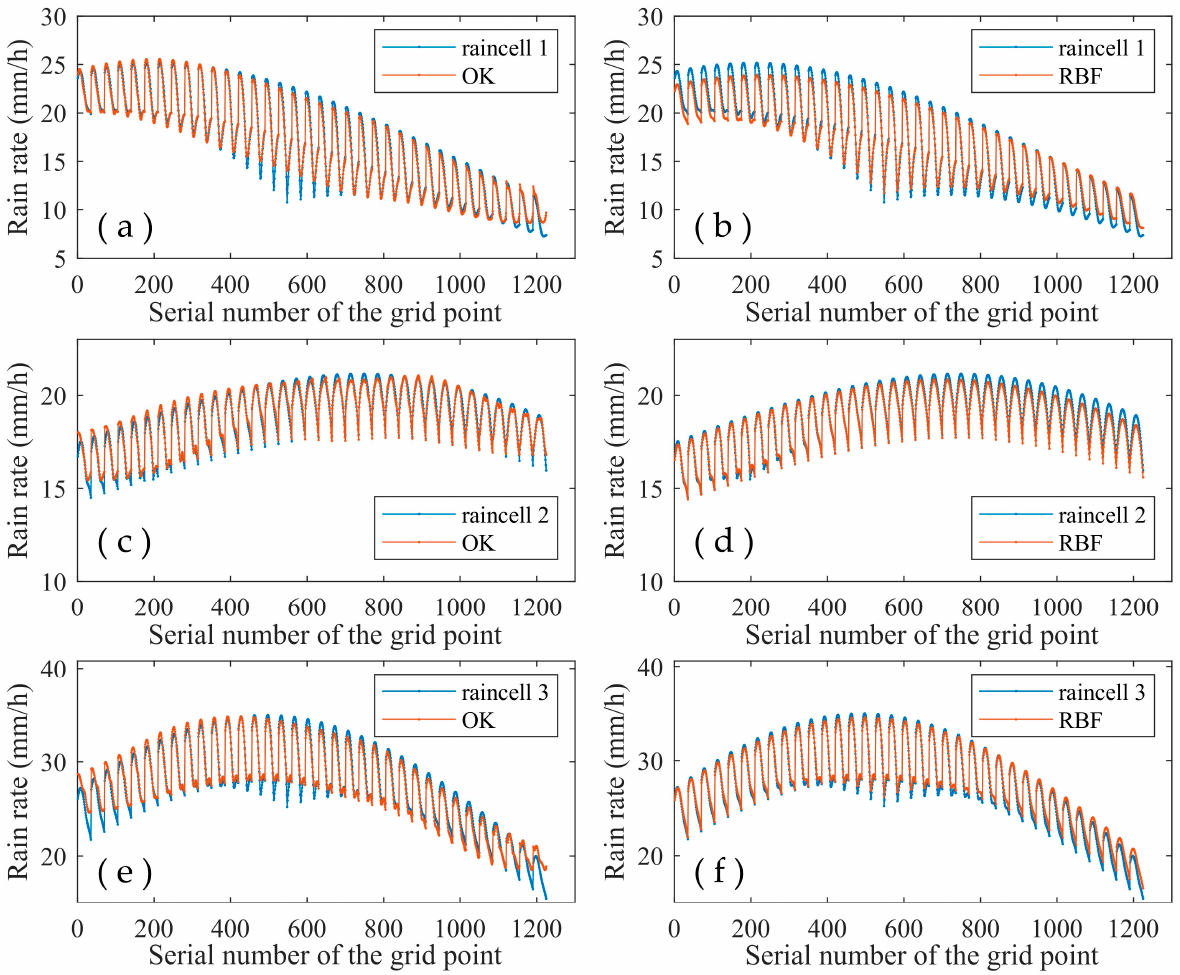
Figure 8. The results of joint net of ESLs and HMLs retrieving the rain rates of the different rain cells. ( a , c , e ) are the rain rates of the different rain cells retrieved by the OK algorithm, and ( b , d , f ) are the rain rates of the different rain cells retrieved by the RBF neural network. Table 3. The results of the joint network of ESLs and HMLs retrieving the different rain cells.